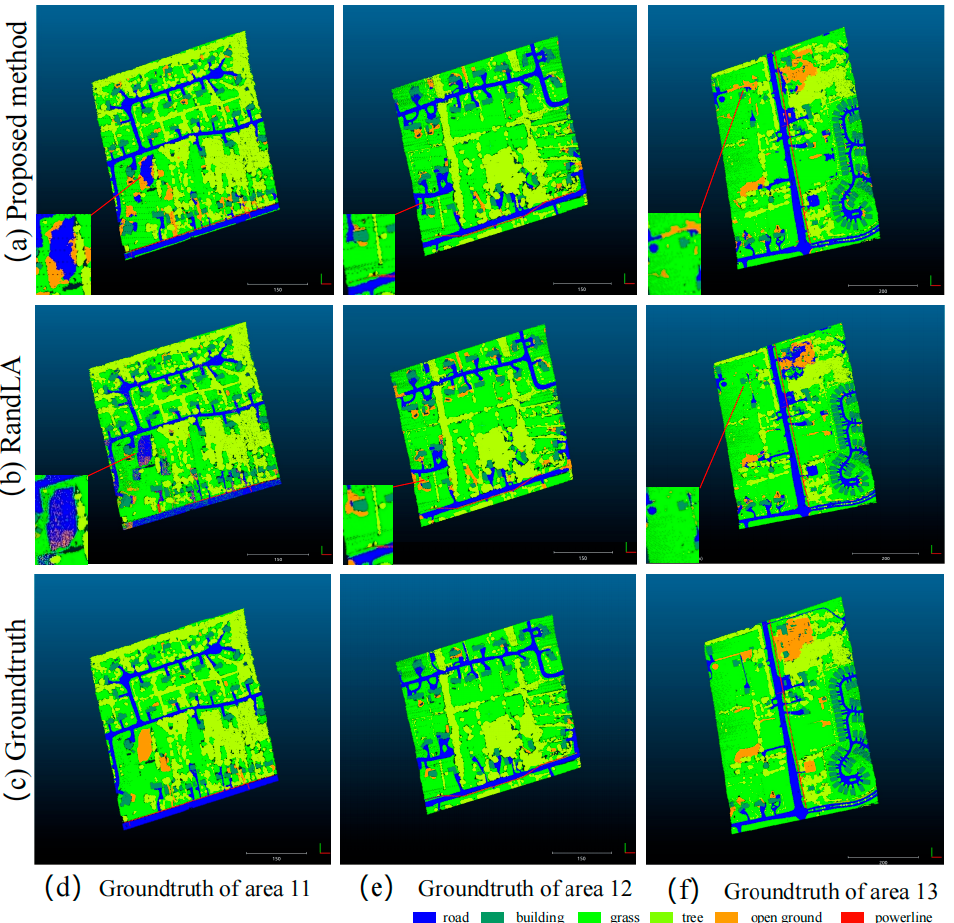
Figure 10. The visualization output of the original RandLA and the proposed method in this paper.